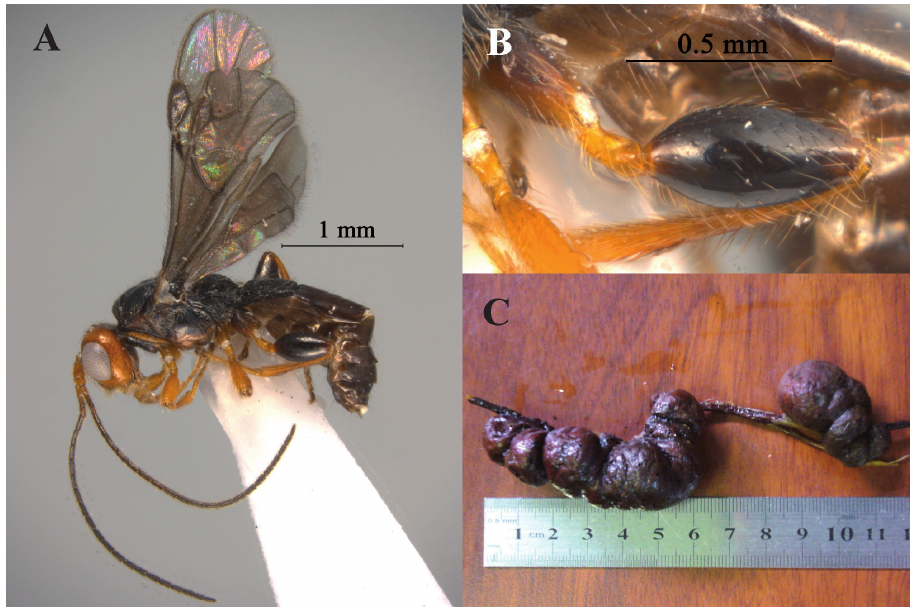
Figure 2. Labania ficophaga sp. n. (male, paratype): A habitus, lateral view B hind femur C Aerial root galls on F. obtusifolia Kunth where specimens of L. ficophaga were